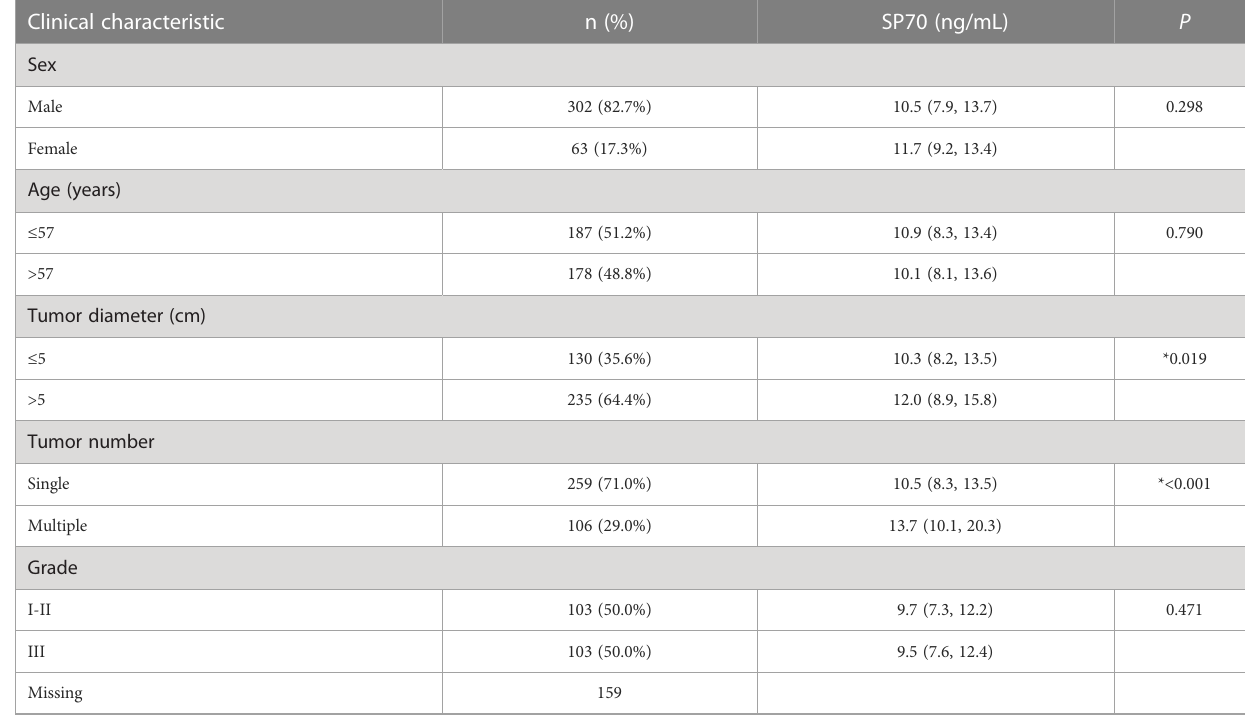
TABLE 1 Clinicopathological characteristics and serum SP70 levels of HCC